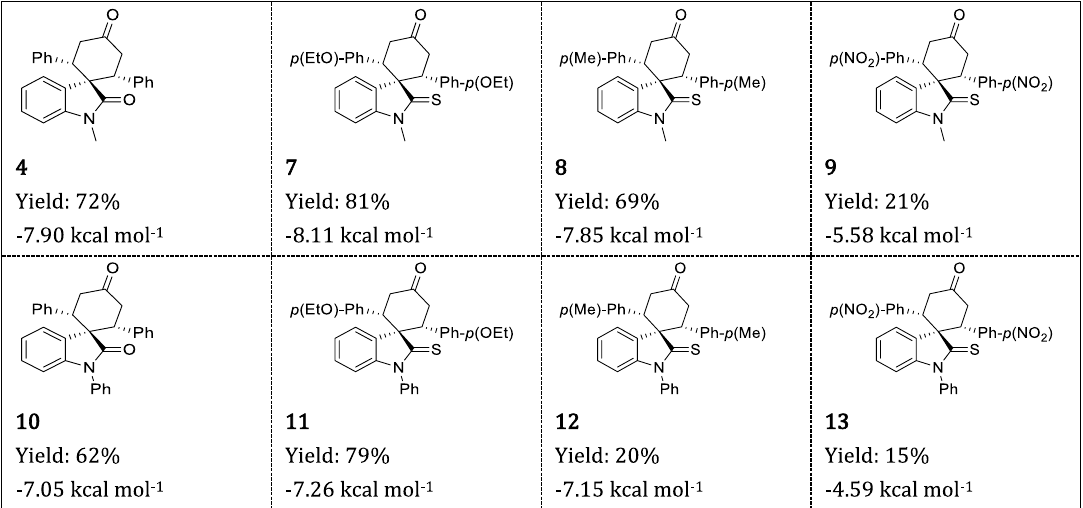
Table 3. Double Michael addition of thiooxindole on dibenzalacetone, reaction yield, and binding energies (kcal mol −1 ) with OPRT domain of LdUMPS.